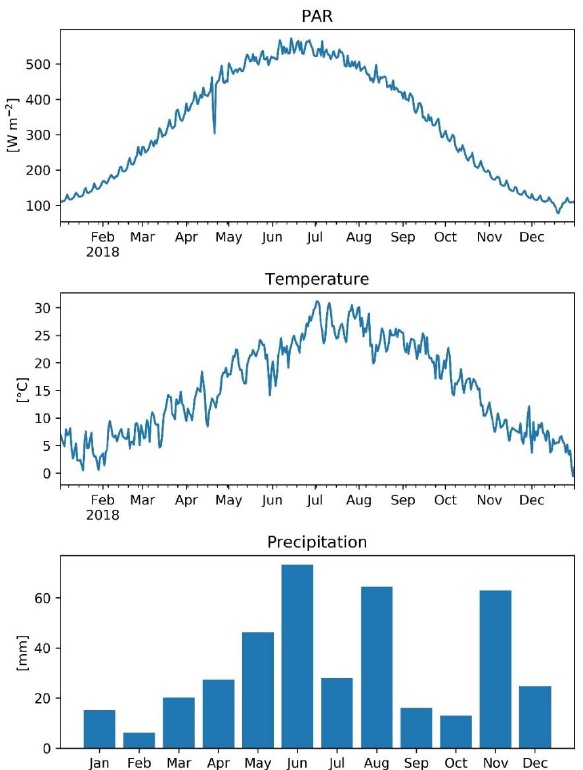
Figure 2. Weather data used for model simulation of Tbilisi in 2018. From top to bottom: daily average photosynthetically active radiation (PAR), daily average air temperature, and total monthly precipitation.